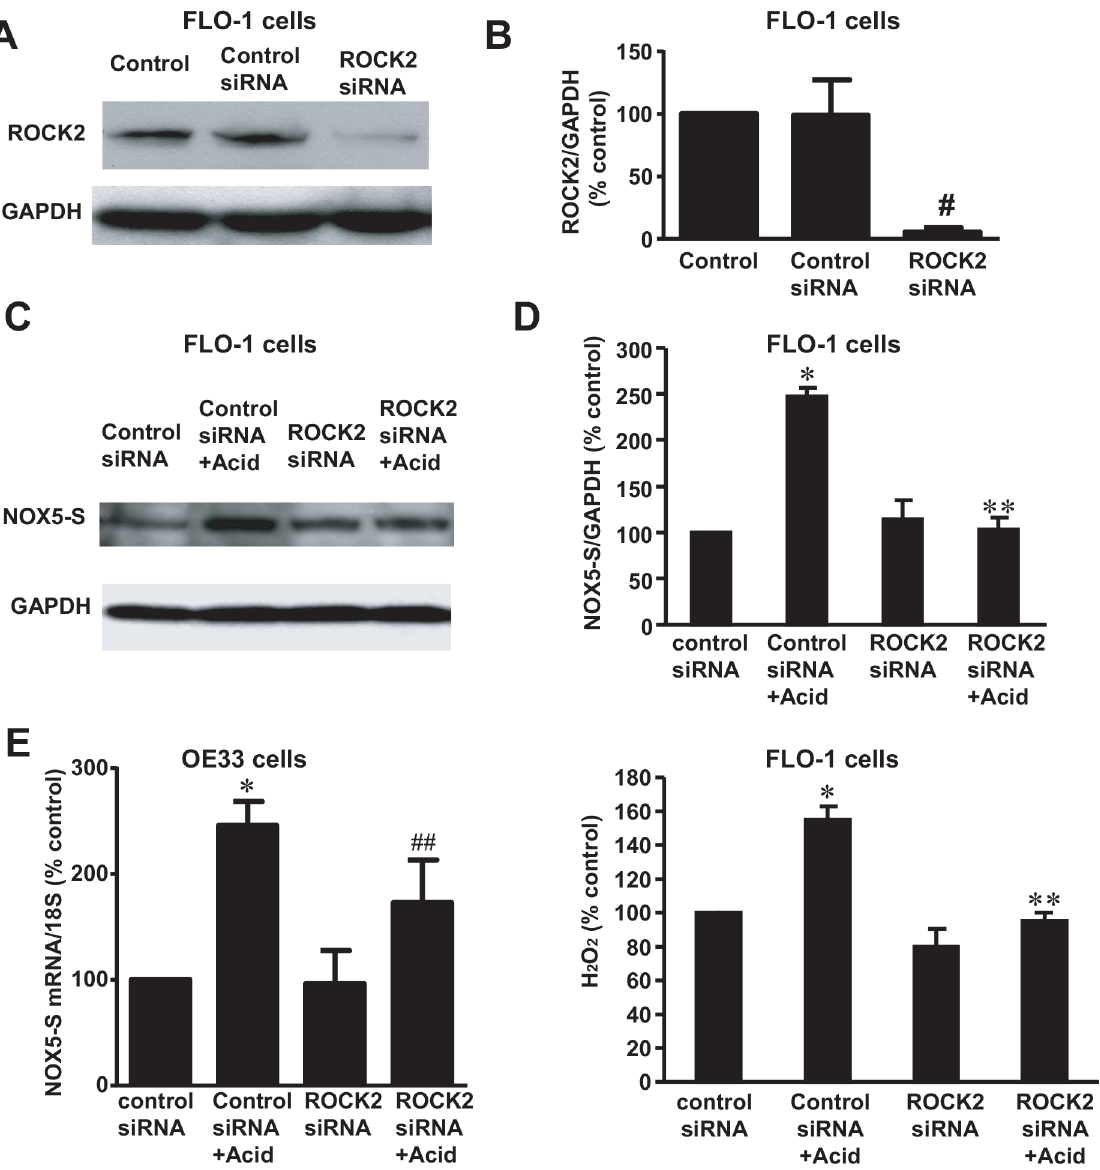
Fig 2. Role of ROCK2 in acid-induced NOX5-S expression in FLO-1 and OE33 EA cells. (A) A typical example of three Western blot analysis and (B) summarized data showed that transfection with ROCK2 siRNA significantly decreased ROCK2 protein expression in FLO-1 cells, indicating that ROCK2 siRNA effectively knocked down ROCK2 protein expression (n = 3). (C) A typical example of three Western blot analysis and (D) summarized data showed that knockdown of ROCK2 significantly decreased acid-stimulated NOX5-S protein expression in FLO-1 cells. (E) Knockdown of ROCK2 significantly decreased acid-induced increase in NOX5-S mRNA expression in OE33 cells. (F) Knockdown of ROCK2 significantly decreased acid-induced H 2 O 2 production in FLO-1 cells. The data suggest that ROCK2 kinase might mediate acid-induced NOX5-S expression and H 2 O 2 production in FLO-1 EA cells. N = 3, ANOVA, * P < 0.01, compared with control siRNA group; ** P < 0.001 & ## p < 0.05, compared with control siRNA + acid group; # P < 0.05, compared with control or control siRNA